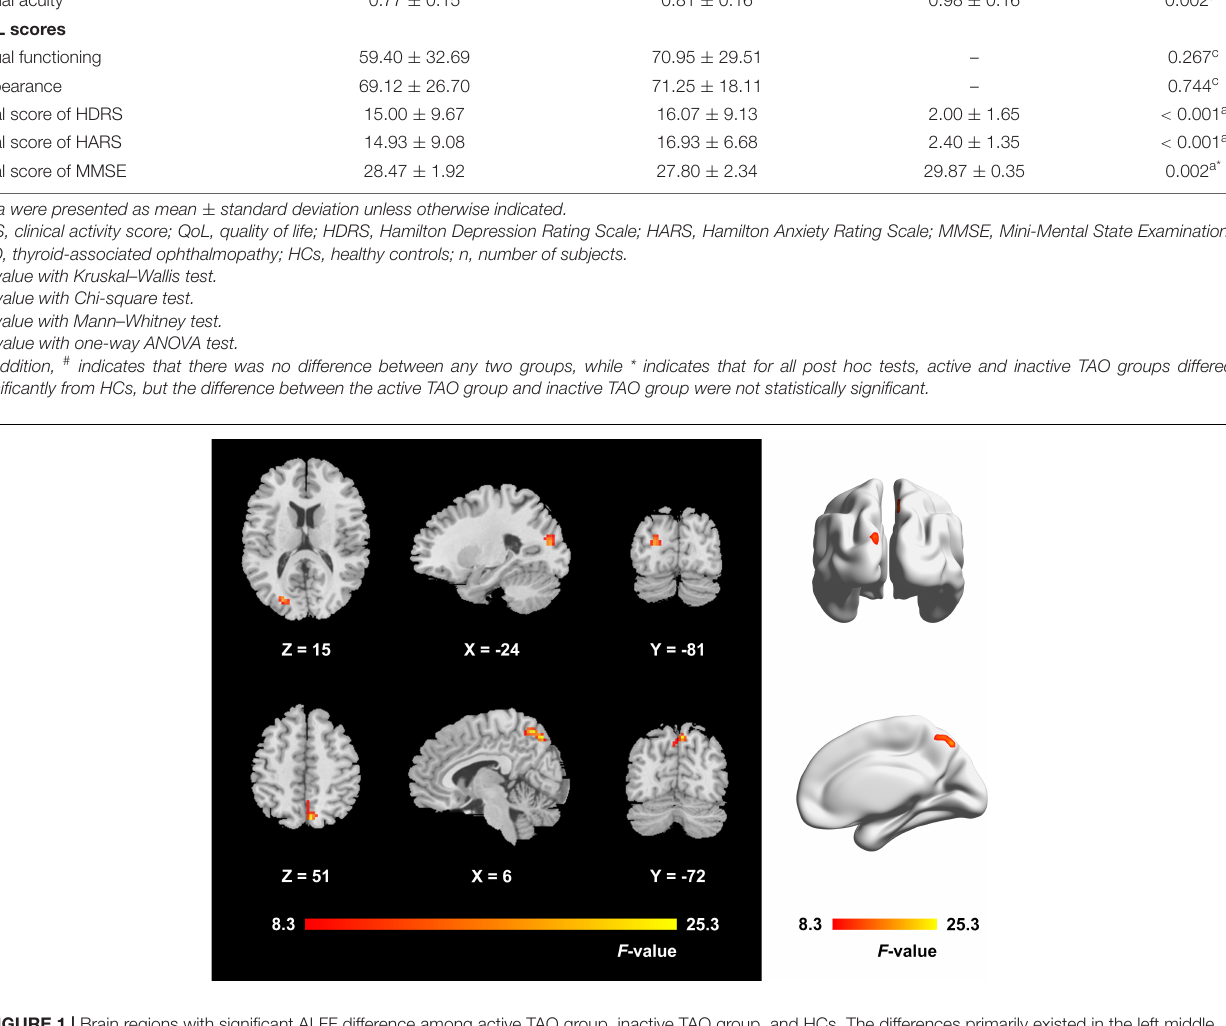
FIGURE 1 | Brain regions with significant ALFF difference among active TAO group, inactive TAO group, and HCs. The differences primarily existed in the left middle occipital gyrus, superior occipital gyrus, cuneus, and bilateral precuneus (voxel P < 0.001, cluster P < 0.05, cluster-level FWE corrected, cluster size ≥ 67 voxels). The color bar indicates the F value from analysis of covariance among the three groups. ALFF, amplitude of low frequency fluctuation; TAO, thyroid-associated ophthalmopathy; HCs, healthy controls; FWE, familywise